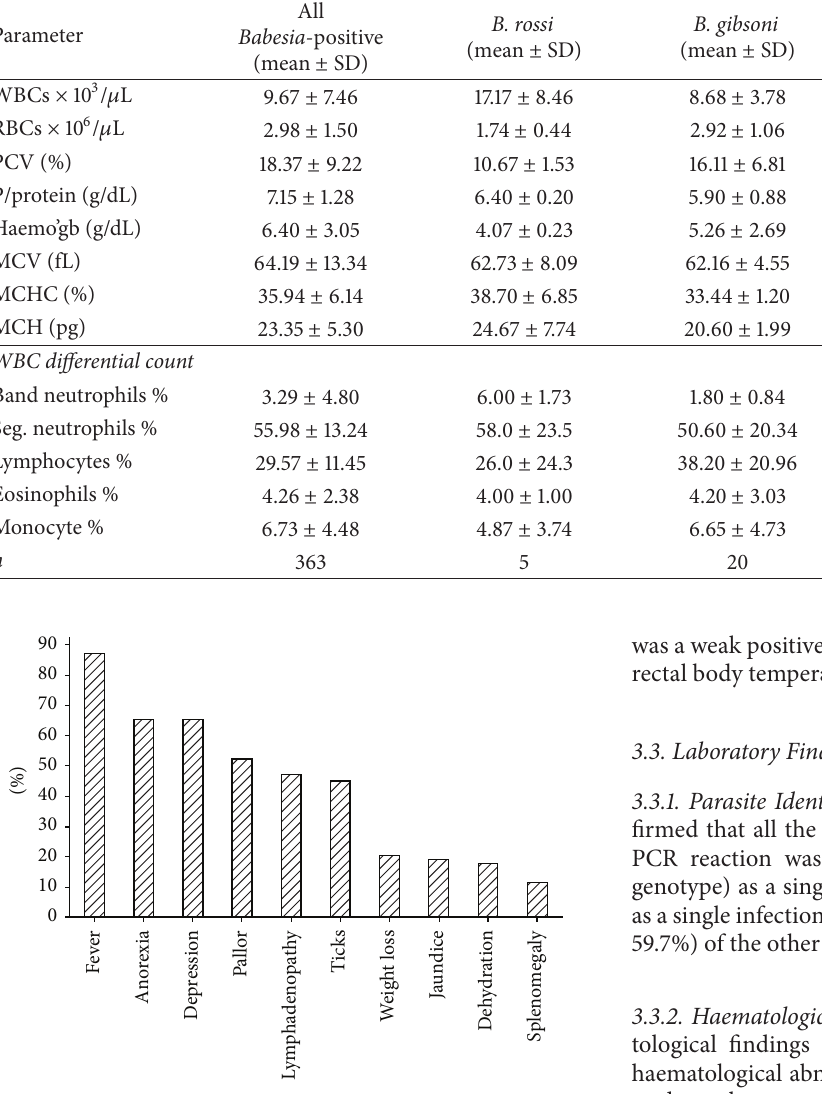
Figure 2: The ten (10) most commonly seen clinical signs and presenting problems associated with Babesia infection in dogs in Zambia ( 𝑛 = 363